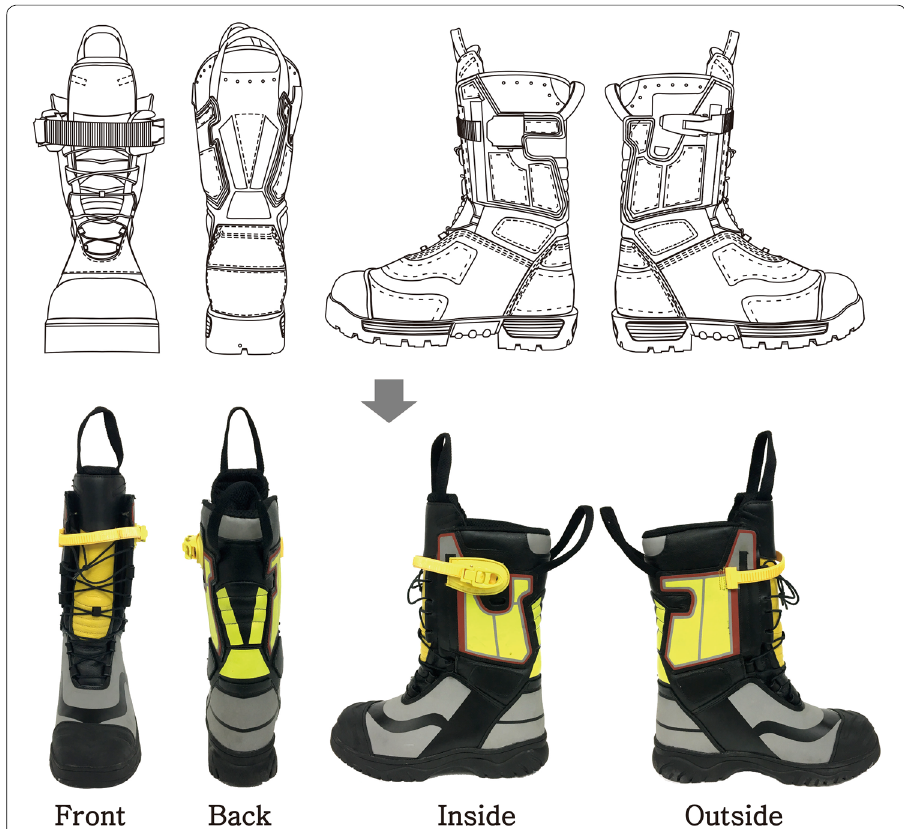
Fig. 3 Protective footwear prototype I with improved